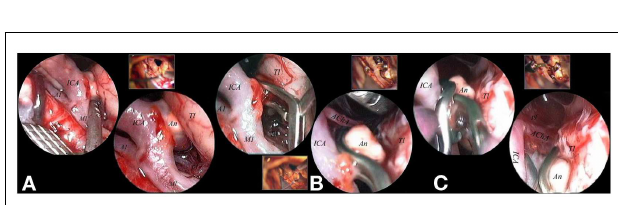
FIGURE 5 |The lesion appeared indoved into the temporal parenchyma (A) . A straight forward 0° scope, used free-hand, allowed a clear vision of the high number of functional perforators surrounding the lesion, without any need to mobilize nor the nor the parental artery. Functional perforators were present both on the superior and of the inferior aspects of the aneurysmal implant base (A) .The scope was fixed and the aneurysm was clipped with a S-shaped clip applied under direct endoscopic control (B) . A second clip was applied in front of the first one to obtain the complete control of the implant base without endangering the anterior choroidal artery, which originated immediately anterior to the implant base itself (C) . A1, proximal segment of the anterior cerebral artery; AChA, anterior choroidal artery; An, aneurysm; ICA, internal carotid artery; M1, proximal segment of the middle cerebral artery; pf, perforator;Tl, temporal